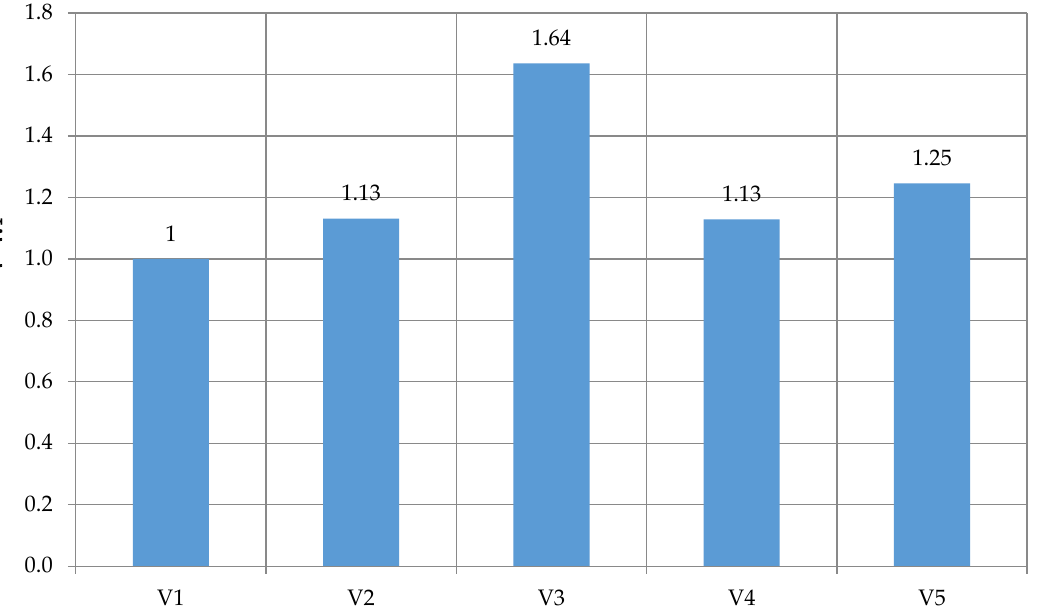
Figure 5. Influence of the cycle structure on its efficiency as compared to variant 1 for heating value W d = 8.5 MJ/kg.